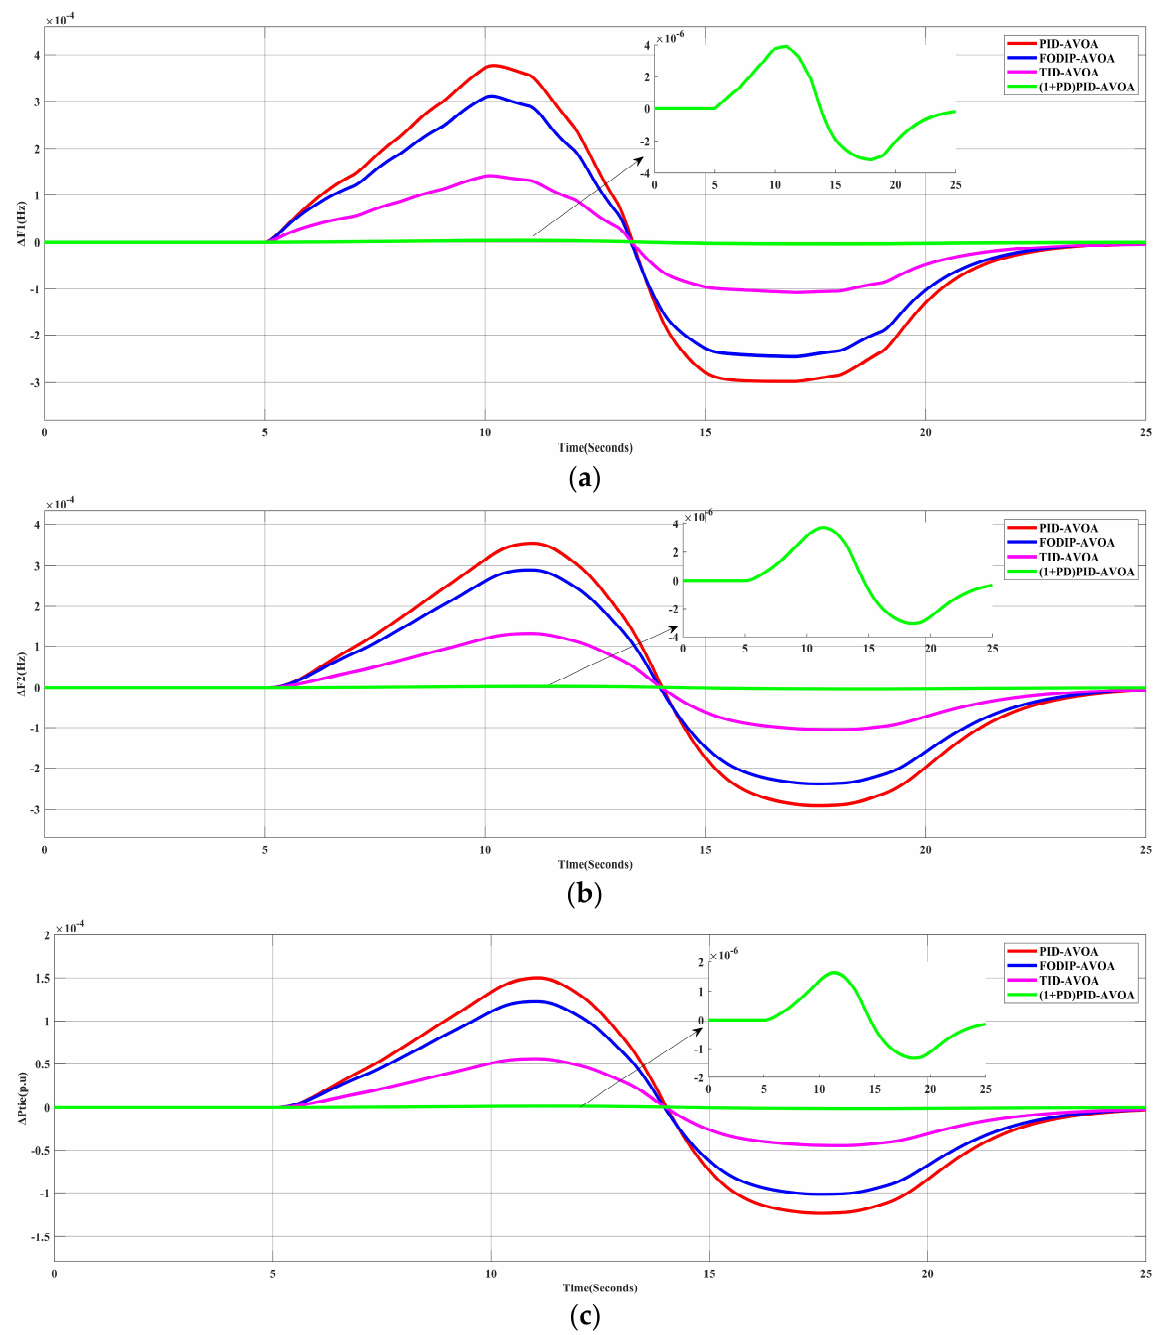
∆ F ∆ P 1 , ( b ) 2 and ( c ) tie